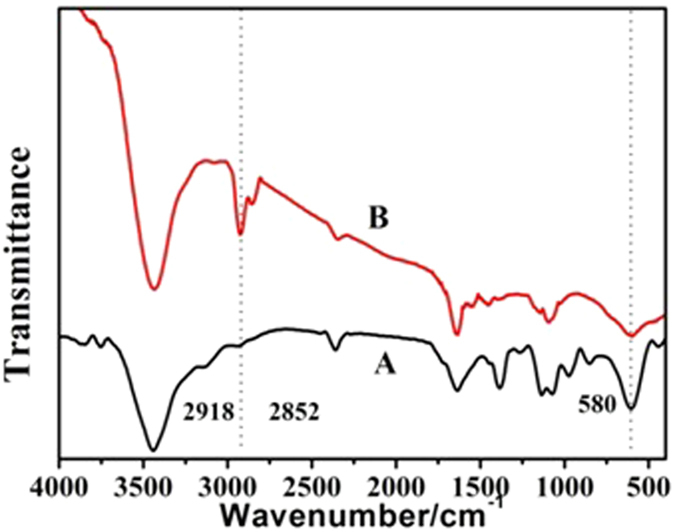
FT-IR spectra of Fe3O4 NPs (A) and C16mimBr-coated Fe3O4 NPs (B).